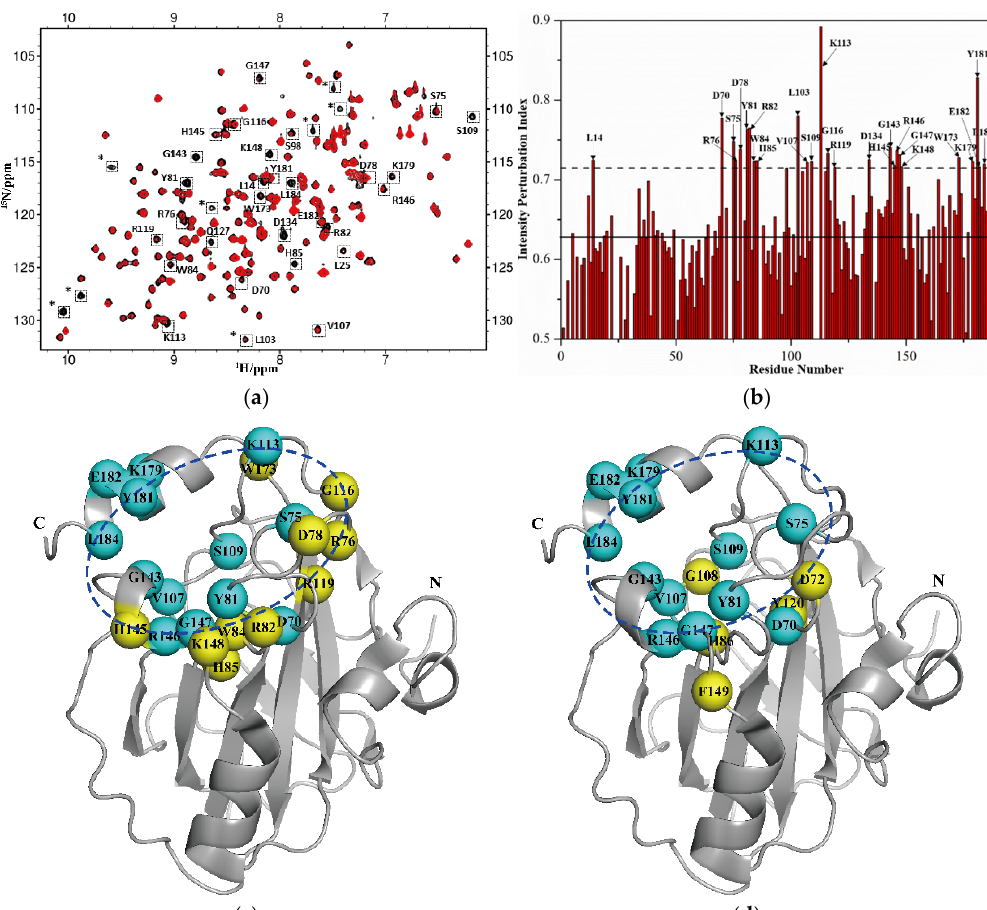
Figure 2. Binding sites of suramin on hRKIP determined by nuclear magnetic resonance (NMR) spectroscopy ( a ) Overlaid 1 H- 15 N HSQC spectra of hRKIP in the absence (black) and presence (red) of suramin at 1:1 molar ratio. * represents unassigned peaks from the residues located at the linker between target gene and the vector. ( b ) The intensity perturbation indexes versus residue number. Solid line: the average value of intensity perturbation index; Dashed line: average + SD. ( c ) Residues with significant broadened peaks are mapped to the solution structure of hRKIP (PDB: 2L7W). Dashed circle: the ligand-binding pocket of hRKIP. ( d ) Residues involved in the hRKIP- hRaf1 NTD interaction are mapped to the same 3D structure [36]. Cyan balls: common residues involved in the interactions of hRKIP with both suramin and hRaf1 NTD . Yellow balls: specific residues for the interaction of hRKIP with either suramin or hRaf1 NTD .